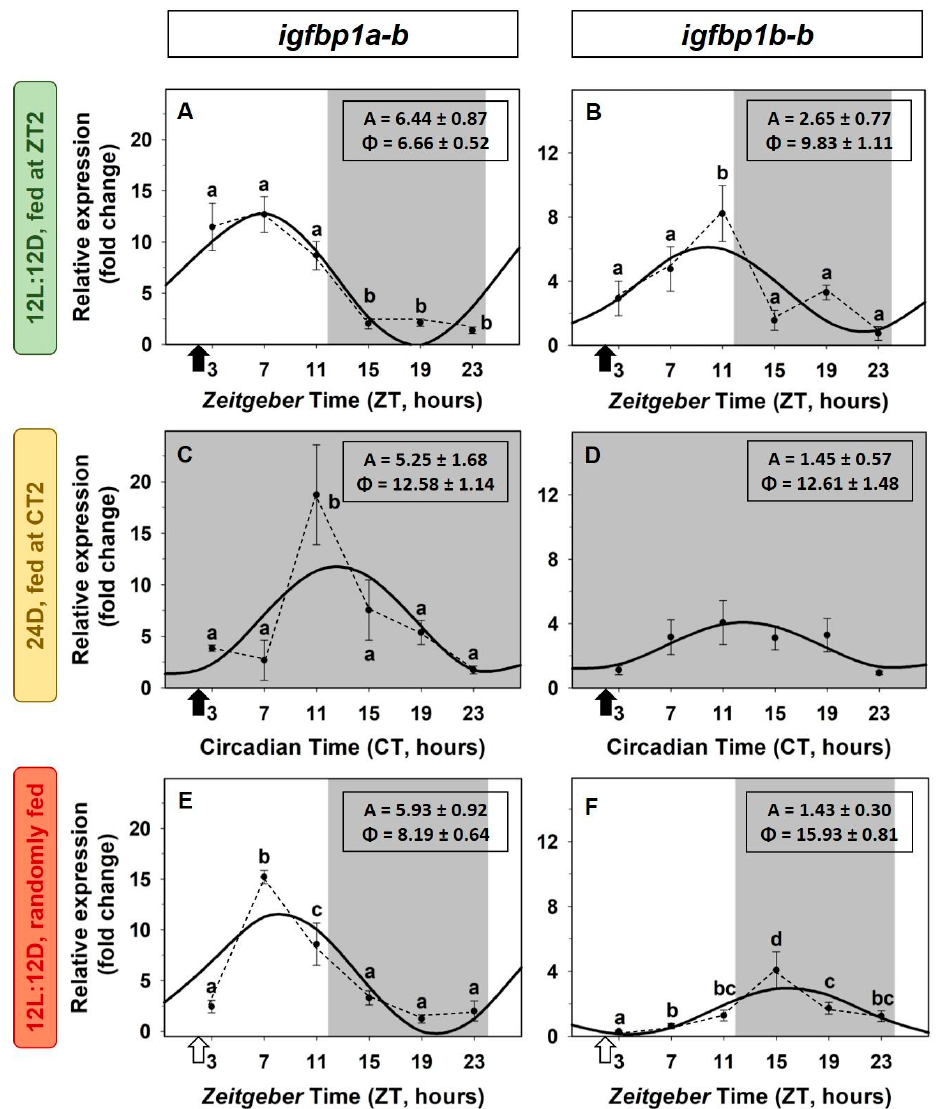
Figure 3. Daily variations of igfbp1a-b ( A , C , E ) and igfbp1b-a ( B , D , F ) expression in the liver of goldfish. ( A , B ) Standard conditions group (12L:12D photoperiod, feeding time at ZT2); ( C , D ) 24D group (24 h darkness, feeding time at CT2); ( E , F ) random feeding group (12L:12D photoperiod, randomly fed). Data are expressed as mean ± s.e.m. ( n = 7/sampling time). Different letters indicate statistical differences among sampling times (ANOVA). Sinusoidal waves represent significant rhythms by cosinor analysis. Dashed lines represent significant differences among sampling points by ANOVA. Black arrows indicate feeding time. White arrows indicate the time of the last feeding. The dark period is represented in grey. Parameters defining the rhythms (A: amplitude, φ :